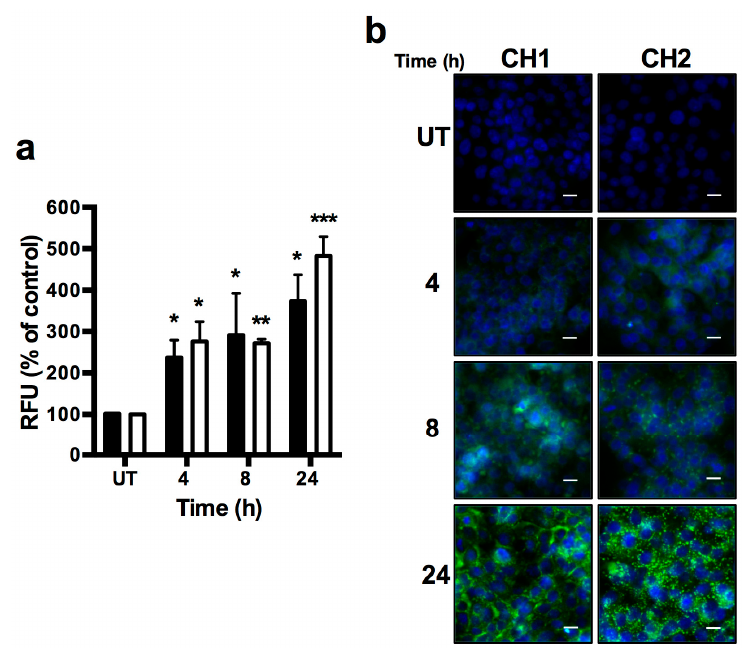
Figure 11. Chalcone effects on the HepG2 cells; Intercelular reactive oxygen species generation. CH1 and CH2 enhanced cellular ROS level. Cells were exposed to CH1 and CH2 at 50 μ M for 4, 8 and 24 h. ( a ) Stained cells with DCFDA and analyzed by fluorescence in a plate reader (Tecan infinite ® m200pro, Grodig, Austria); ( b ) Stained cells with DAPI (blue) and DCFDA (green), and analyzed under fluorescent microscopy EVOS ® FLoid ® cell (Life Tehnologies, CA, USA), Black bars represents CH1 and White bars represents CH2. Data are expressed as the mean ± standard error of the mean (SEM) from three independent experiments, each performed in triplicate. Statistical differences were assessed by a one-way ANOVA (Kruskal–Wallis) followed by Dunn’s post hoc test. * p < 0.05; ** p < 0.01; *** p < 0.001 vs. Untreated (UT) group. Bar scale represents 20 μ m.